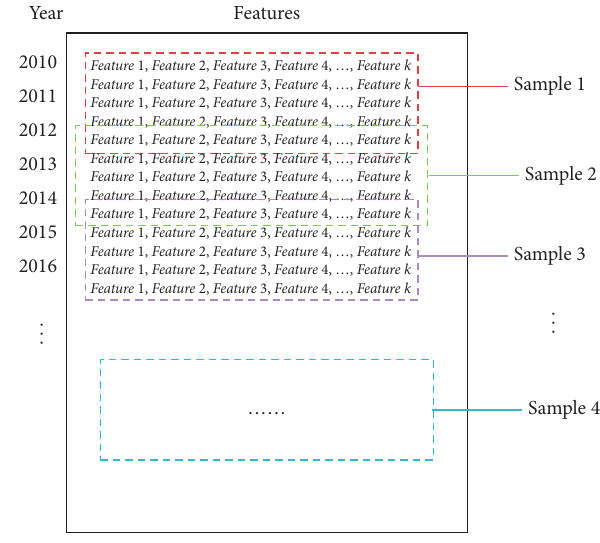
Figure 2: Sliding sample